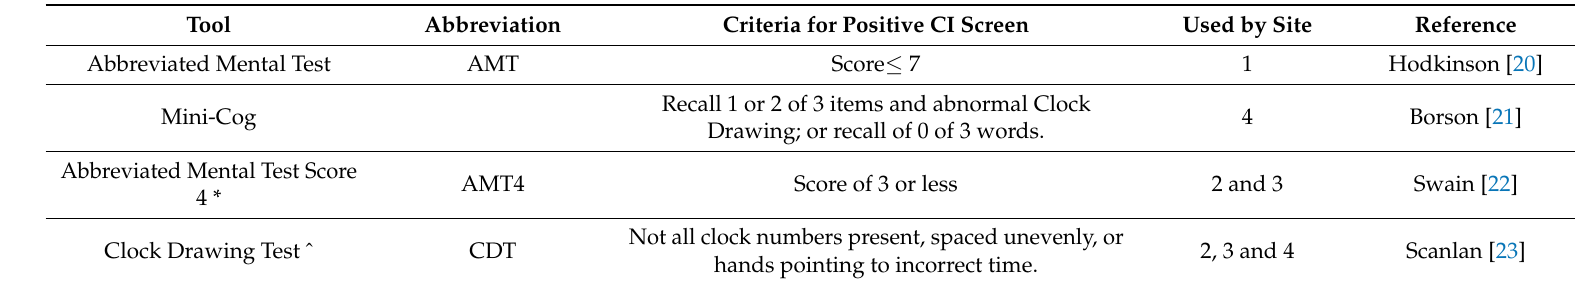
Table 2. Cognitive Impairment Screening